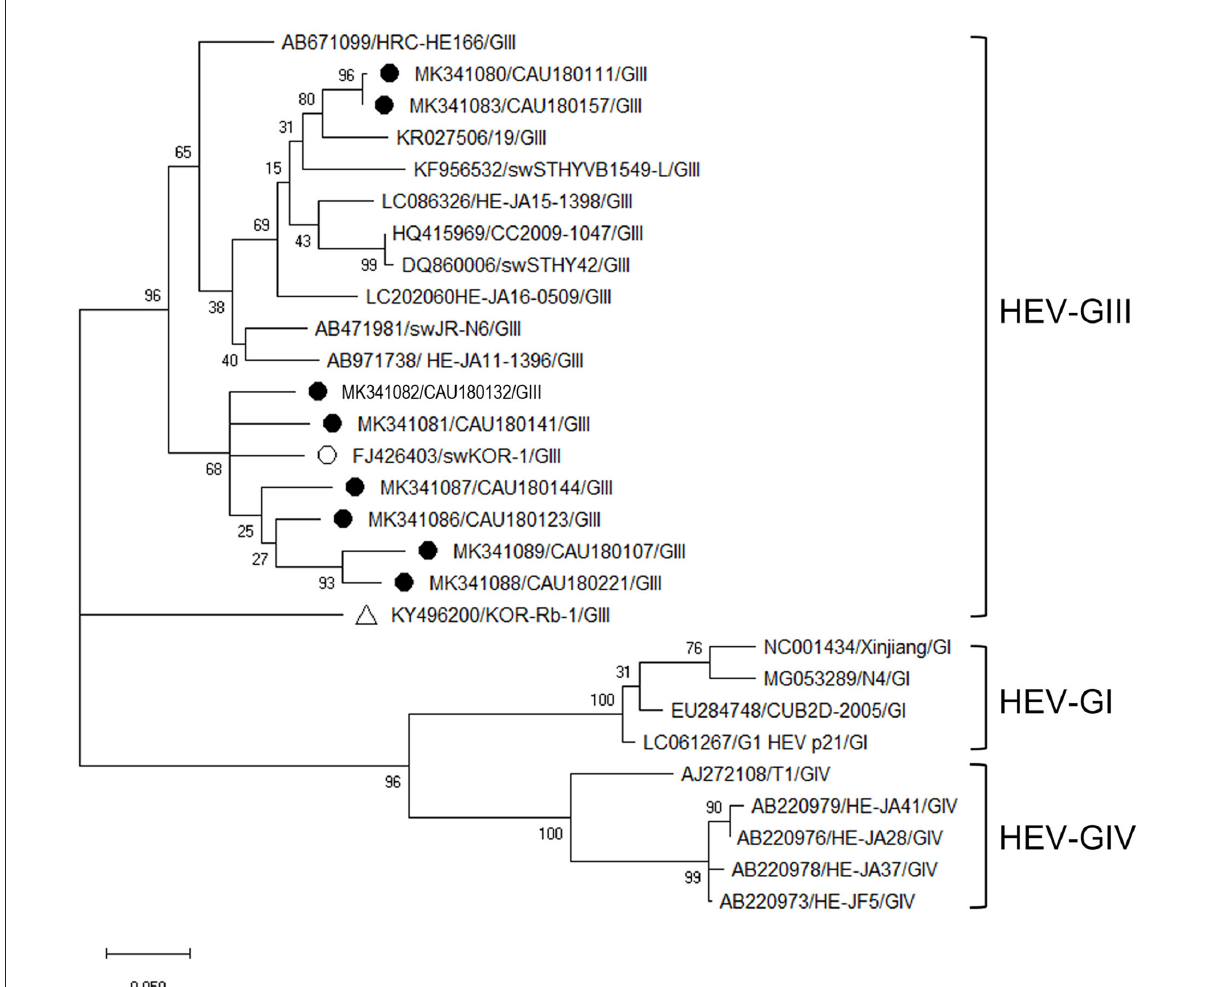
FIGURE4 Phylogenetic analysis of HEV detected in porcine stools and swabs. The HEV phylogenetic tree was constructed following the UPGMA method and based on 348-bp sequences of ORF2 and VP1 overlapping region. Sequences detected in this study are represented as black circles (•). The reference sequences of porcine HEV (FJ426403/swKOR-1) and rabbit HEV (KY496200/KOR-Rb-1) strains detected in the Republic of Korea are labeled with white circle ( ◦ ) and triangle ( 1 ) , respectively. The phylogenetic analysis included HEV-GI (four strains), HEV-GIII (11 strains), and HEV-GIV (five strains) as reference sequences. The numbers at the nodes of the tree indicate bootstrap values and the scale bar indicates nucleotide substitutions per